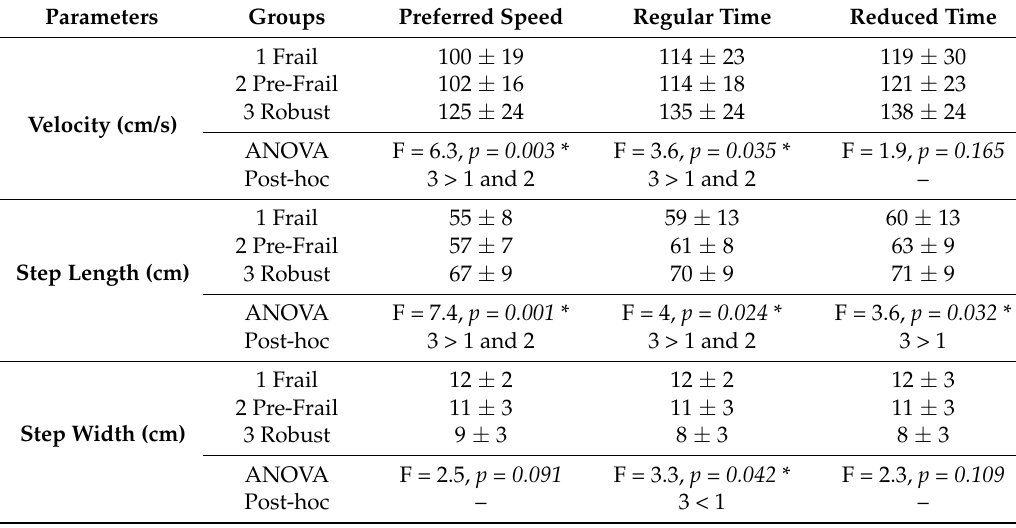
Table 2. Gait parameters by frailty status (means ± standard